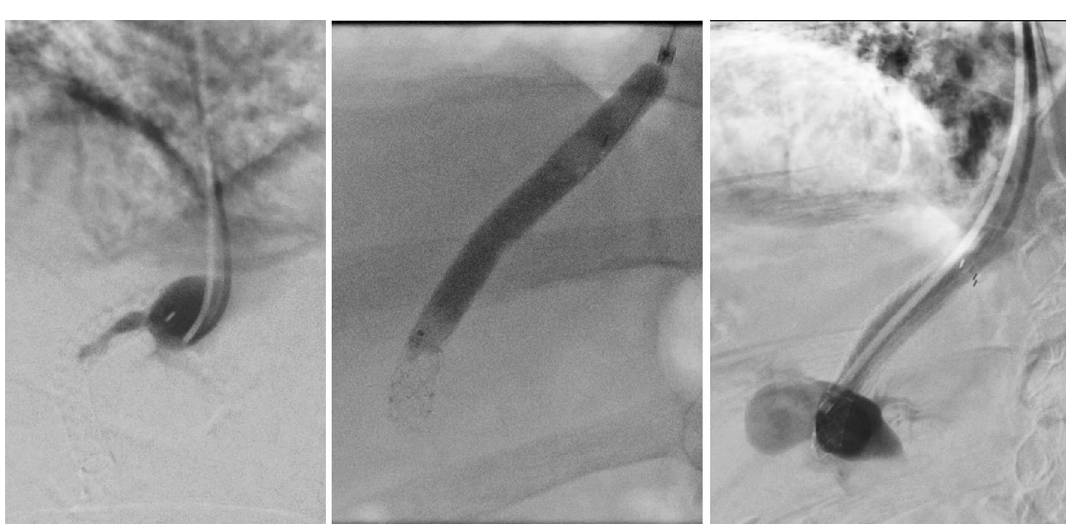
Figure 2. TIPS occlusion. Angiographic evidence of TIPS occlusion at day 23 postinterventional. The patient was previously readmitted with hydropic decompensation and sonographic evidence of early TIPS occlusion. The patency of the TIPS tract was successfully restored by balloon